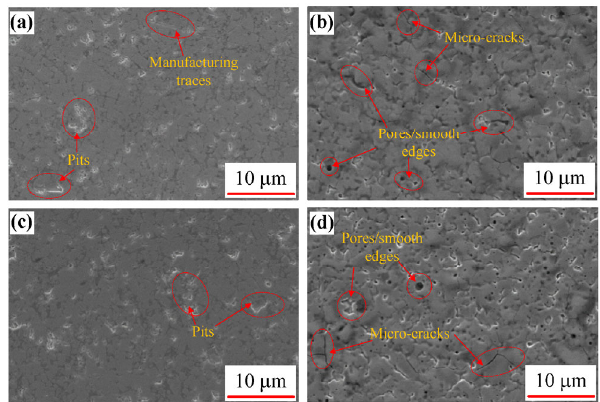
Fig. 4 WC-Ni SEM micrographs: (a) non-irradiated YN6; (b) irradiated YN6; (c) non-irradiated YN10; (d) irradiated YN10.